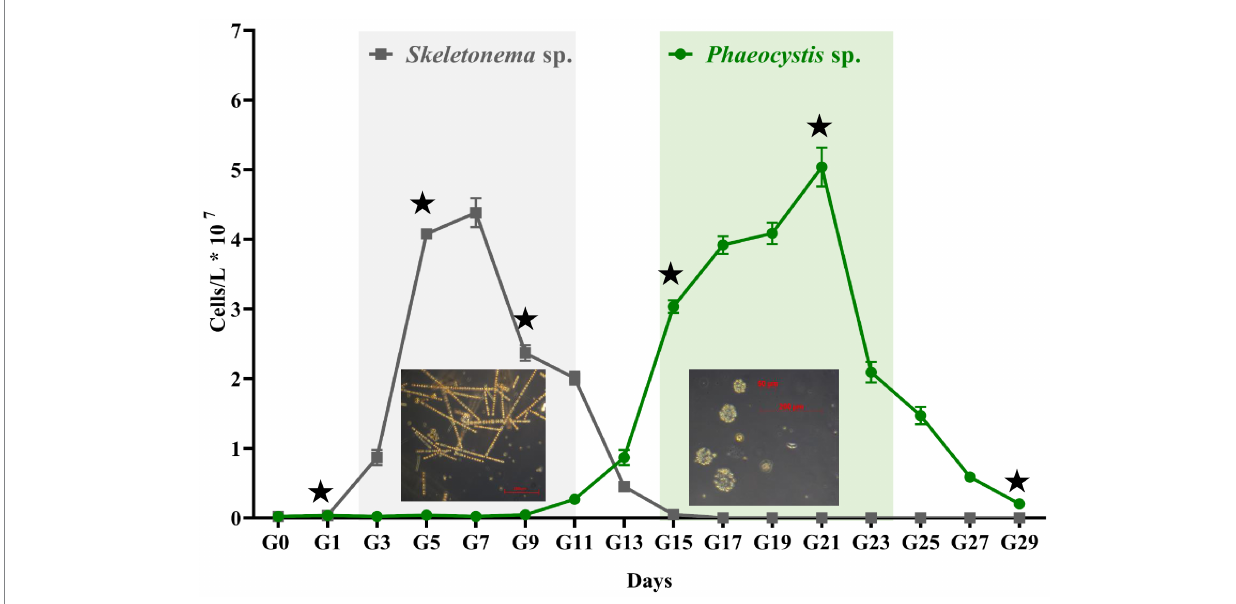
FIGURE 1 The abundance of algal cells counts across the experiment. The gray and green panels represent the Skeletonema sp. and Phaeocystis sp. blooms, respectively. Error bars indicate SD ( n = 6). The asterisk denotes the sampling time for metagenomic sequencing